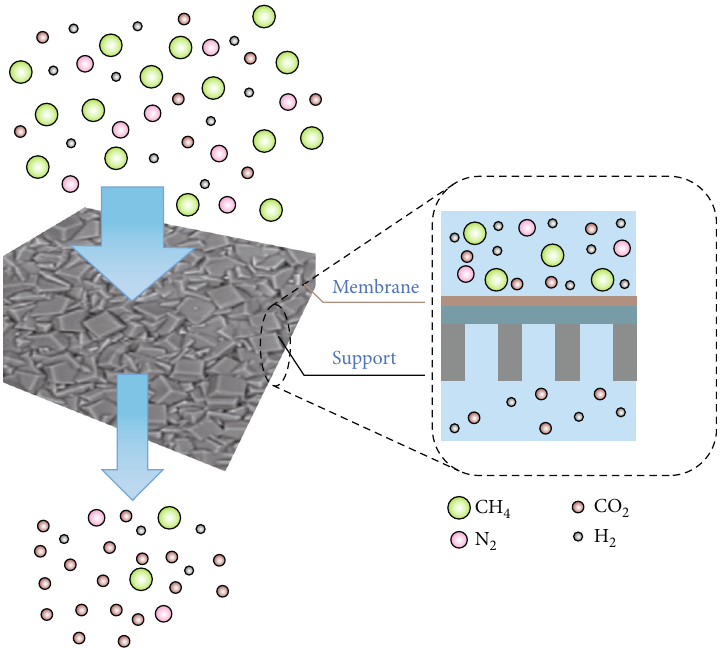
Figure 3: Mechanism of small molecular gas transport over DDR3 membrane.